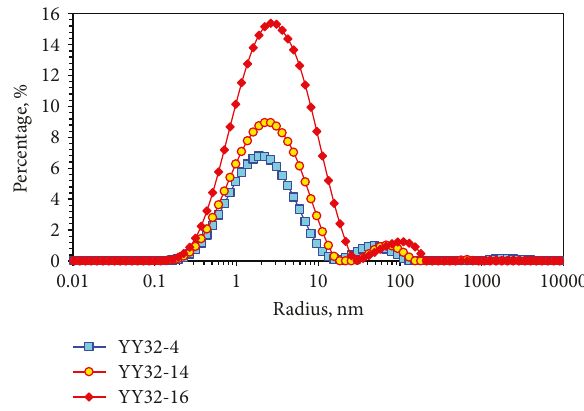
Figure 1: The pore size distribution map for shale gas reservoir in Ordos Basin (P.R.